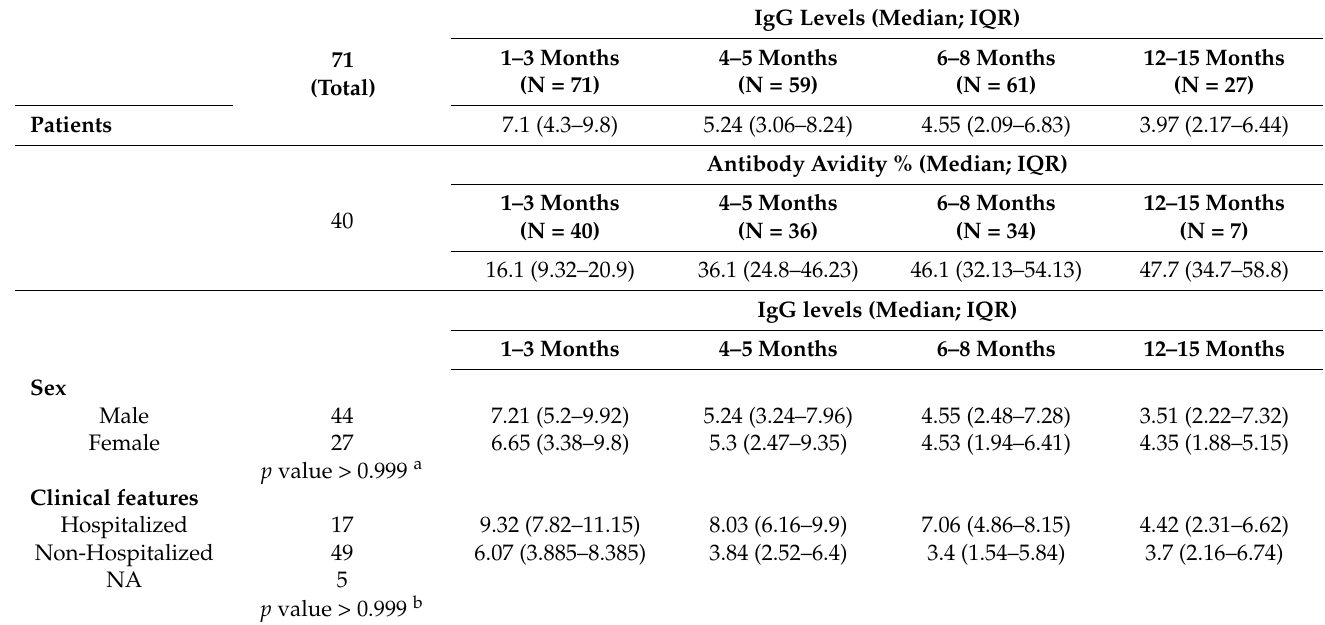
Table 1. Demographic data and anti-SARs-CoV-2 S1 IgG and Avidity titers of COVID-19